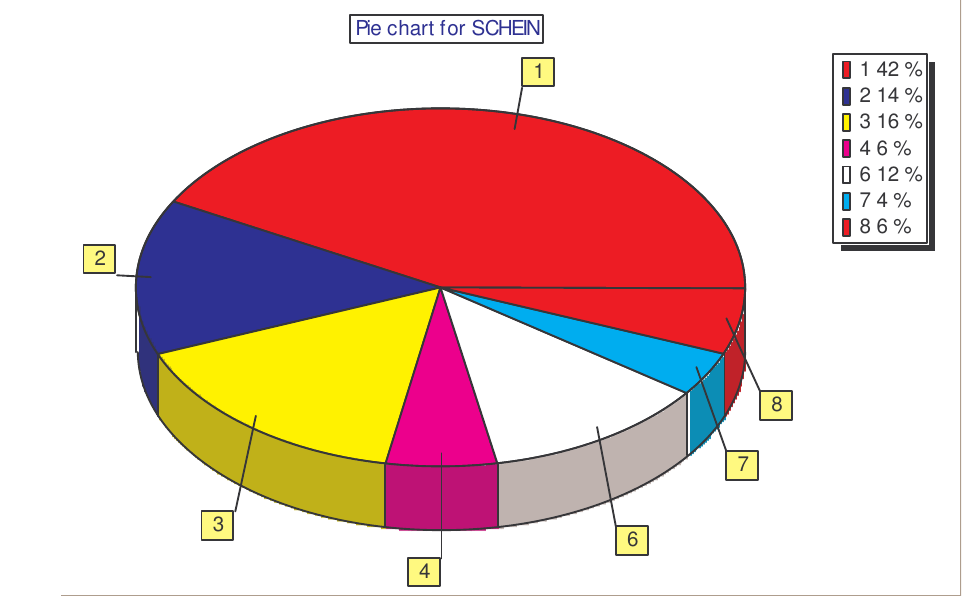
Figure 1: The primary career anchors of